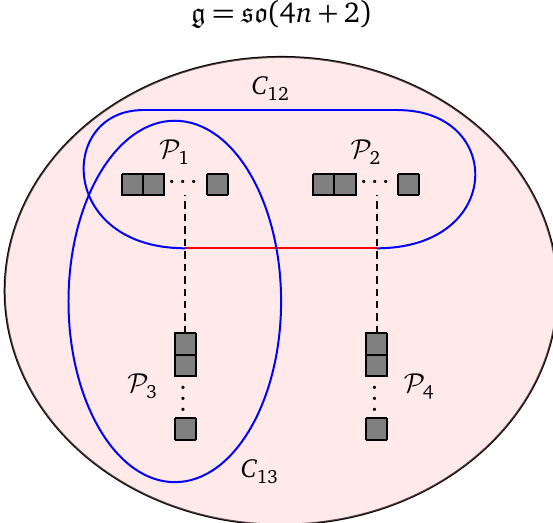
Figure 6: The example considered in the text involves compactification of 6 d N = ( 2,0 ) theory of g = so ( 4 n + 2 ) on a sphere carrying four (cid:90) twisted regular 2 punctures. The dashed lines display the locus of the (cid:90) outer-automorphism twist 2 lines. P and P are maximal punctures and each of them carries an sp ( 2 n ) flavor 1 2 algebra. P and P are minimal punctures and neither of them carries a non-trivial 3 4 flavor algebra. C , which is shown completely in blue, is a cycle encircling P and 13 1 P . C is a cycle encircling P and P , which is divided into two segments, shown 3 12 1 2 in red and blue, separated by outer-automorphism twist